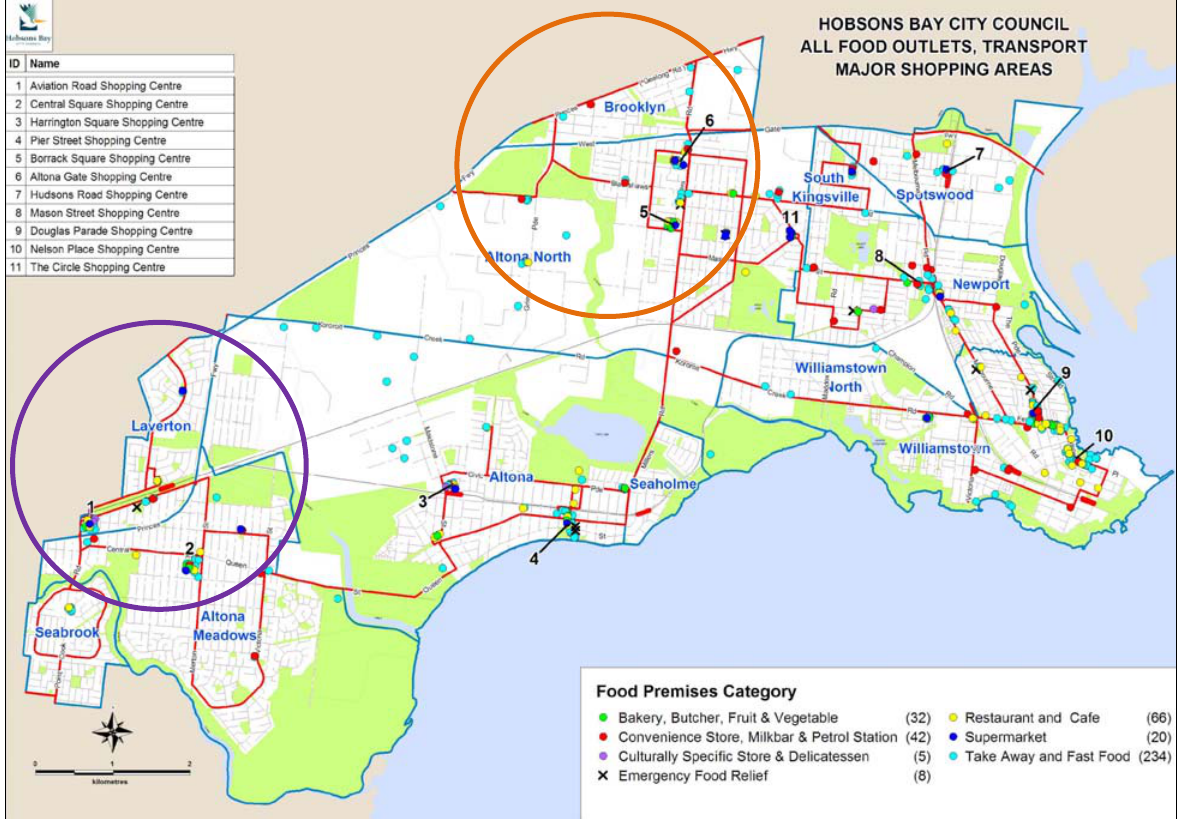
Source: Hobsons Bay City Council